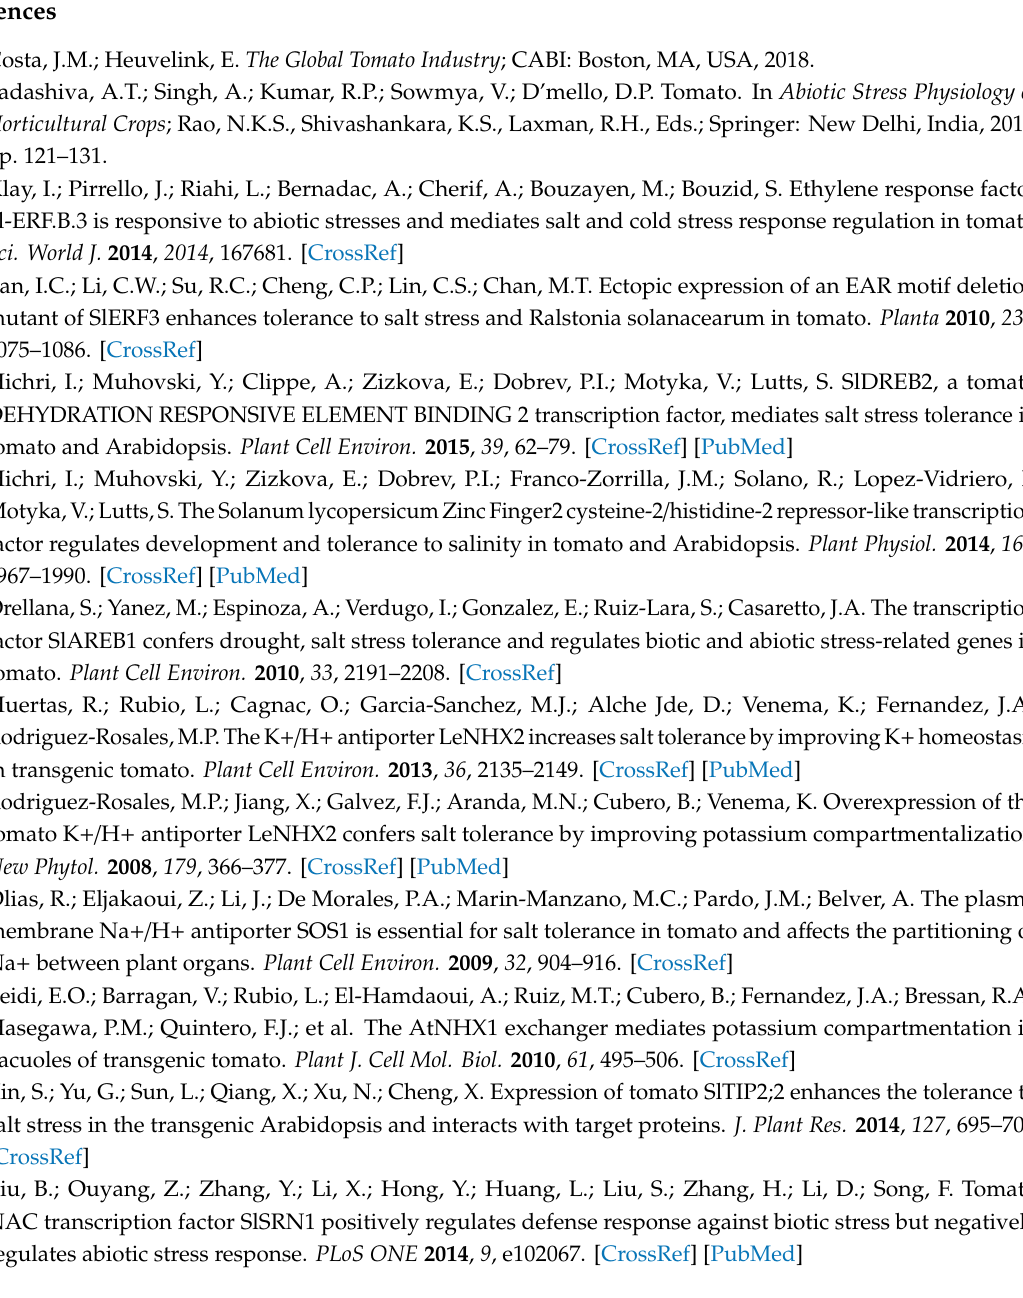
Figure S1 SlPKE1 was responsive to drought stress in three genotypes (M82, IL2-5 and IL9-1) in microarray data [15]. Genes (FDR < 0.05 and fold ≥ 2) were identified as di ff erentially expressed genes. Table S1 Sequence composition of SpPKE1 and SlPKE1. Table S2 Primer sequences used for vector construction and qRT-PCR analysis. File S1 Details of DNA methylation in PKE1 promoter and coding